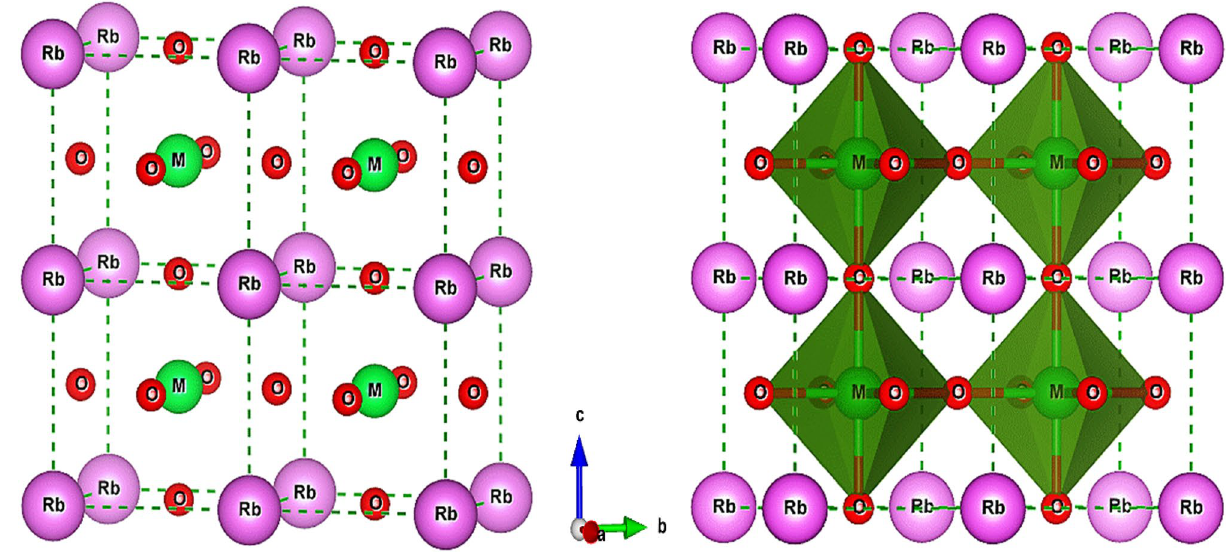
Figure 1. The layout of various atoms in a conventional unit cell (left); and the crystal structure of RbMO 3 perovskites